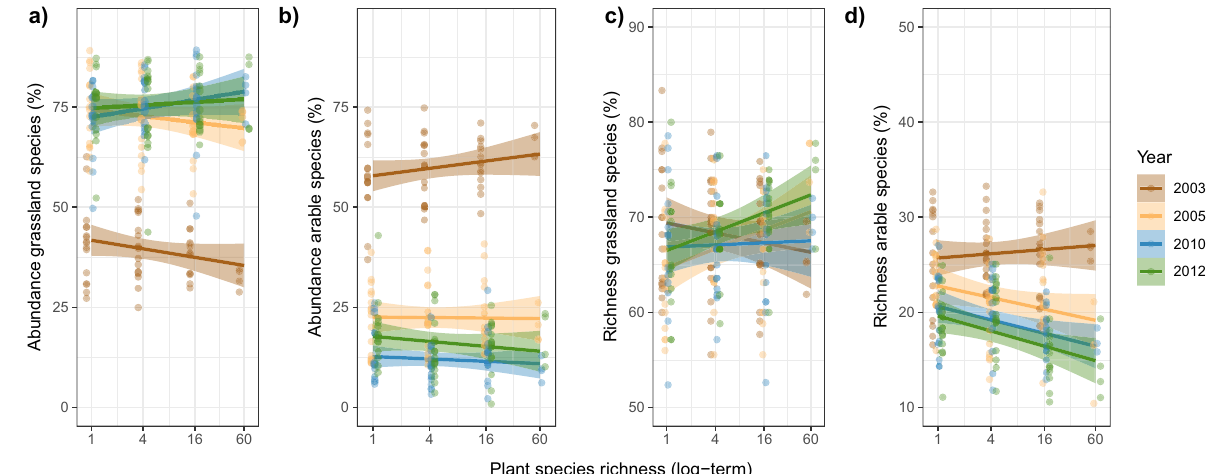
Figure 5. Percentage of ( a ), ( b ) carabid abundance and ( c ), ( d ) species richness of grassland and arable land carabid beetles assigned to grassland and arable land species as affected by plant species richness at different years. Bands in regression plots represent the level of confidence interval (0.95). Dots represent partial residuals for Year and Plant species richness. Please note the different scaling of the y-axes. Block